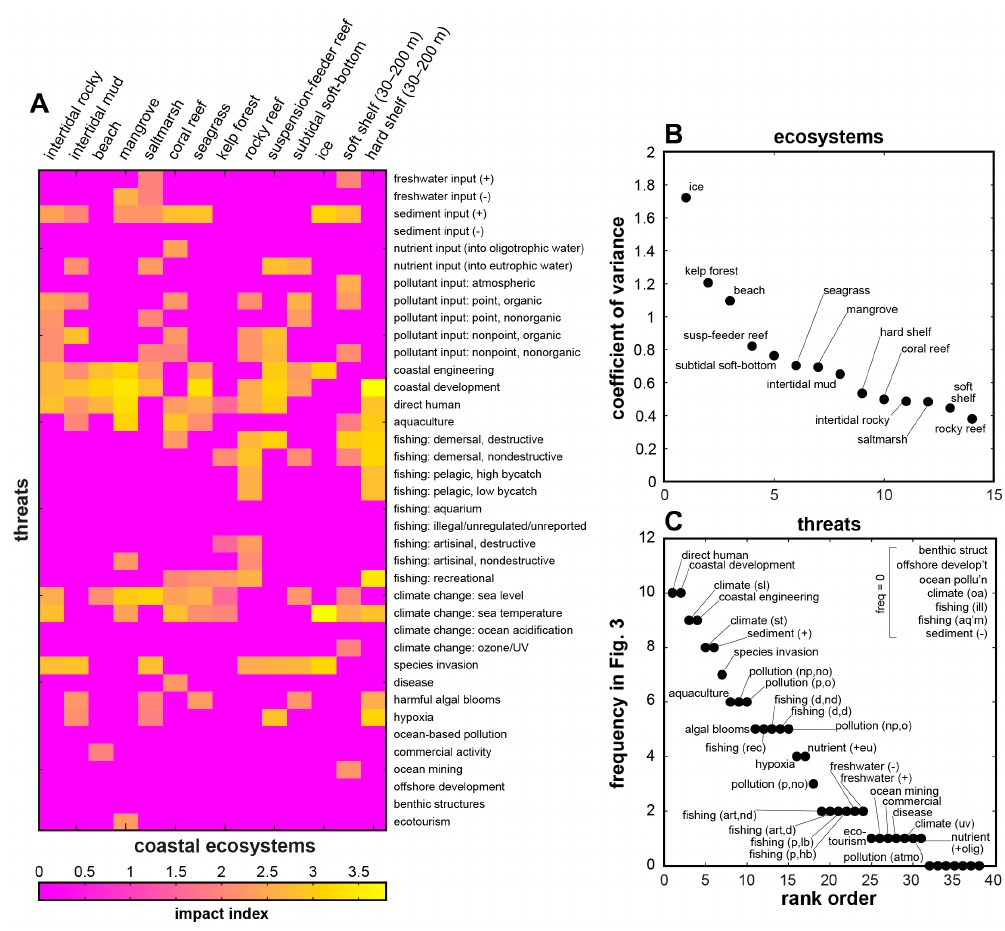
Figure 4. ( A ) Matrix of coastal ecosystems and threats in Figure 2A, filtered by top contributors identified in Figure 3A–N. ( B ) Ranked coefficient of variance (ratio of standard deviation to the mean) per coastal ecosystem across threats, calculated from the full data matrix in Figure 2A. ( C ) Ranked frequency of occurrence across ecosystems for contributing threats labelled in Figure